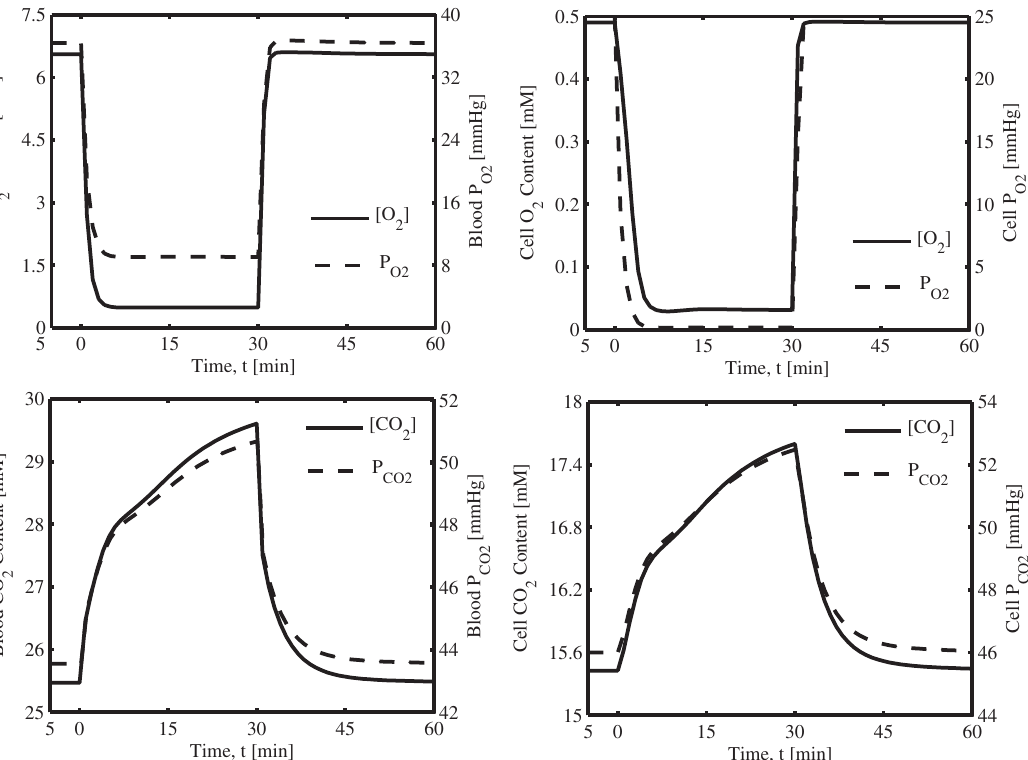
Figure 8. Model-predicted dynamic responses of O 2 and CO 2 (total contents and partial pressures) in the capillary blood (or venous blood) and tissue cells during the resting, ischemia and recovery periods with a blood flow reduction of about 76%. The responses were computed using the estimated optimal parameter values with the ischemia protocol: if ( t , 0 min | t . 30 min) Q =0.9 L/min, else Q = Q isch =0.216 L/min. The total O 2 and CO 2 contents are based on various forms of O 2 and CO 2 transports in the capillary blood and tissue cells (see Materials